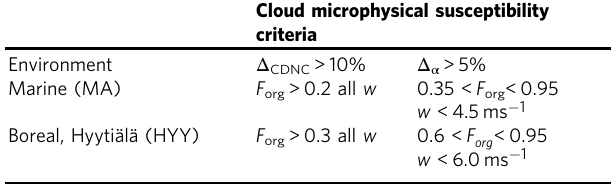
Table 3 Organic mass fraction and updraft criteria, established from Fig. 3b and d, yielding signi fi cant cloud microphysical responses to the surface phase